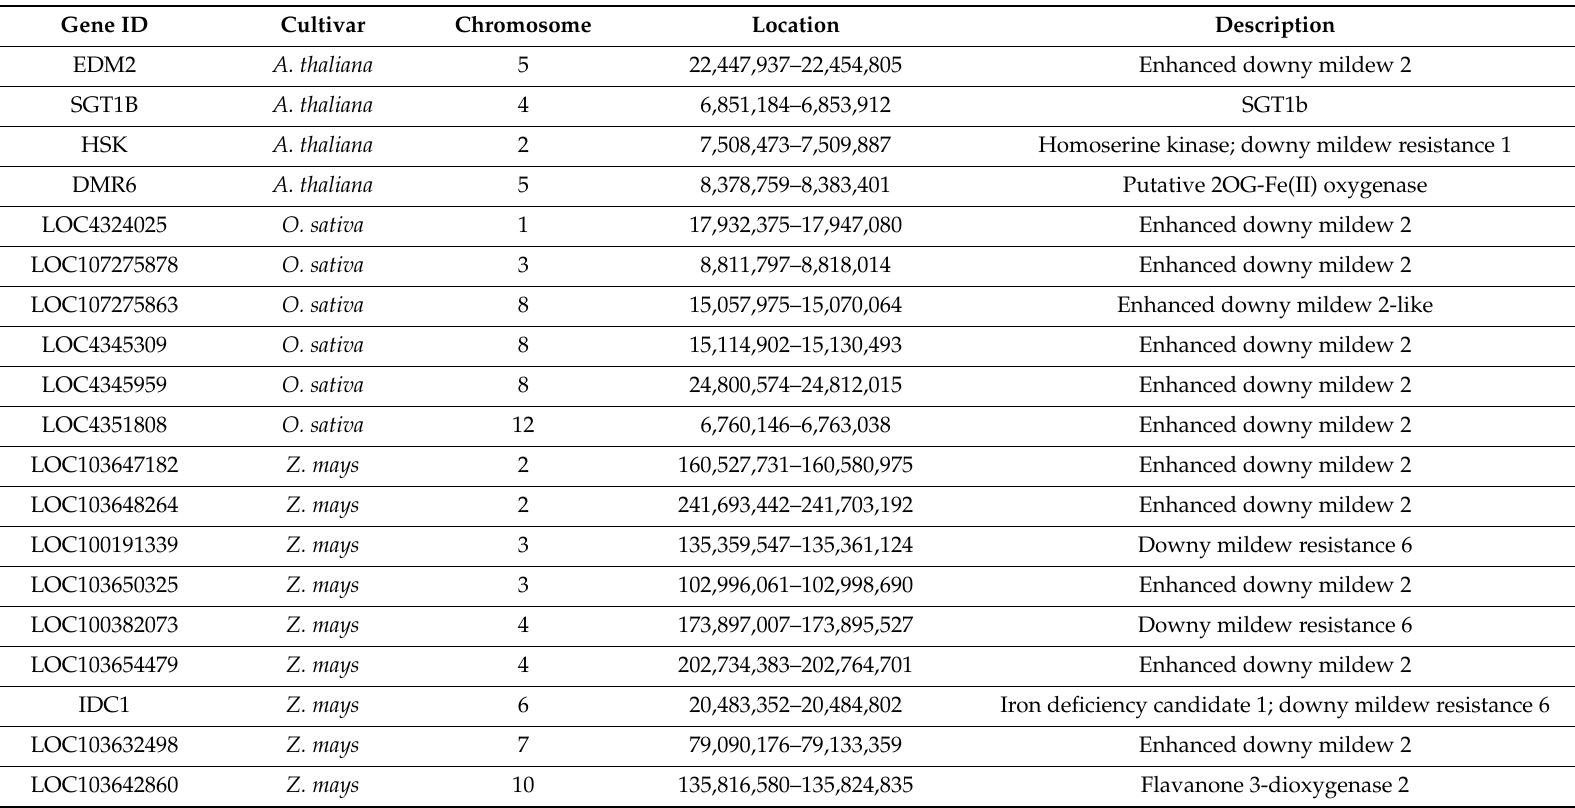
Table 4. List of the DM-related genes in Arabidopsis thaliana , Oryza sativa , and Zea mays obtained from the NCBI Database